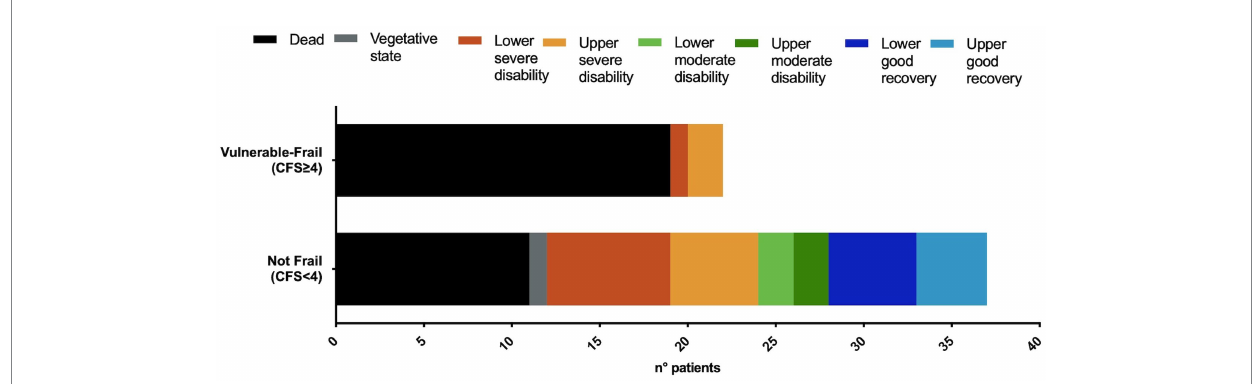
FIGURE 1 Distribution of the extended Glasgow Outcome Scale (GOSE) at 6-months, in vulnerable-frail and not-frail patients. CFS, Clinical Frailty Scale. Dead, GOSE 1; vegetative state, GOSE 2; lower severe disability, GOSE 3; upper severe disability, GOSE 4; lower moderate disability, GOSE 5; upper moderate disability, GOSE 6; lower good recovery, GOSE 7; upper good recovery, GOSE